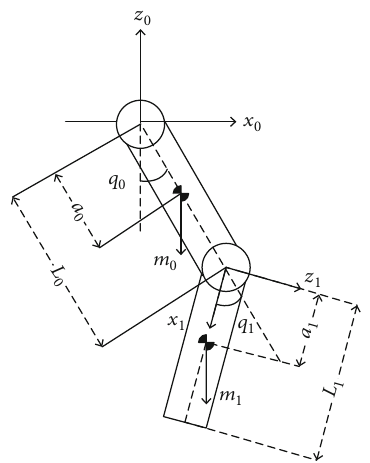
Figure 4: Lower extremity exoskeleton leg ’ s simpli fi ed second link kinetic